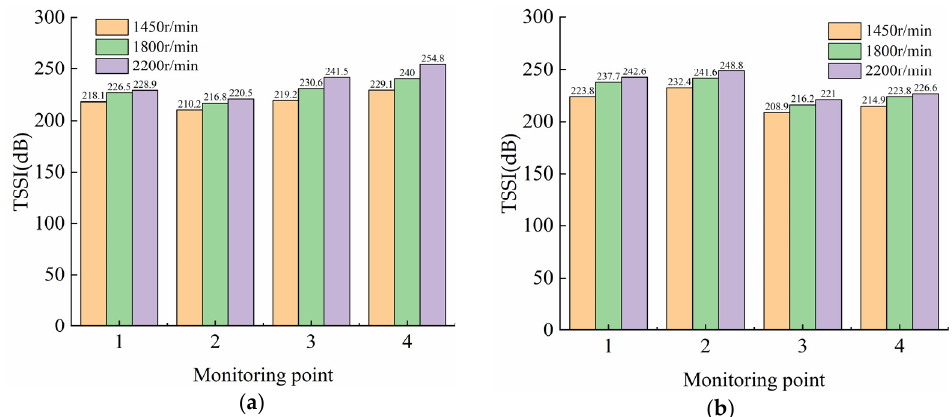
Figure 15. Frequency domain response characteristic curve of TSSI of the inlet and outlet conduits at different rotation speeds. ( a ) TSSI of the inlet conduit. ( b ) TSSI of the outlet conduit.